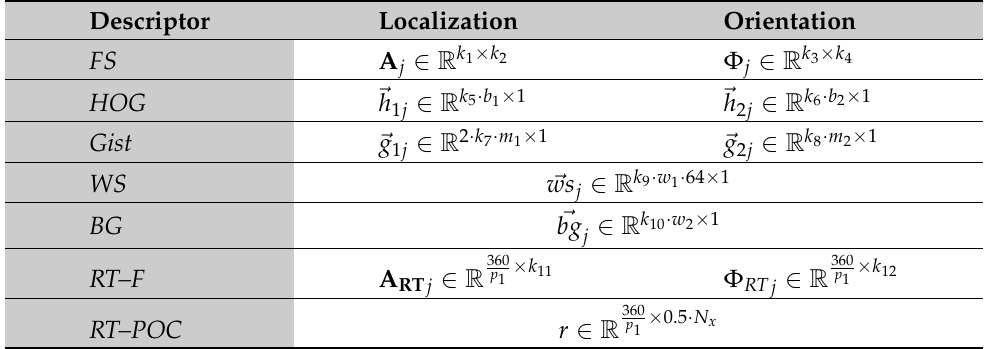
Table 2. Contents of the map, for localization and orientation estimation, per image included in the model im j , j = 1, . . . , n